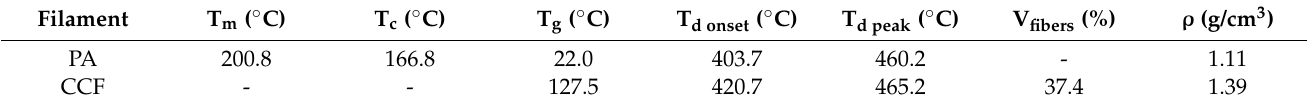
Table 4. Thermal and physical properties of the raw filaments. Melting, crystallization and glass transition temperatures (T m , T c and T g, respectively) were determined by DSC. The glass transition of the PA filament was derived from [39]. Degradation temperatures (T d onset and T d peak ) and fibers volume fraction (V fibers ) were evaluated from TGA